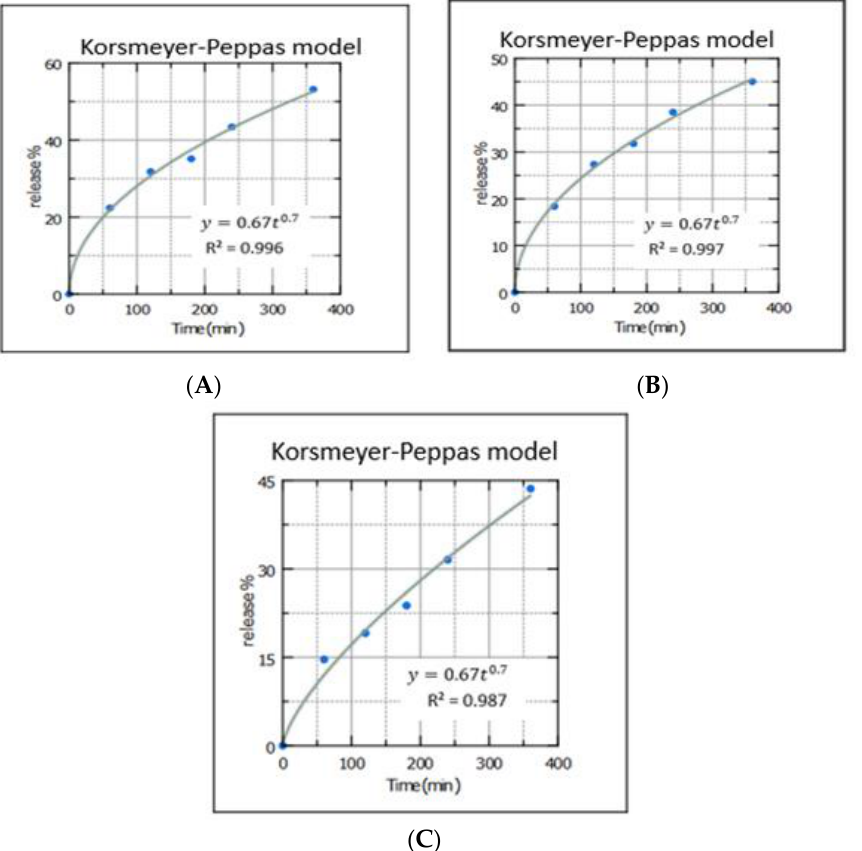
Figure 12. A mathematical model (Korsmeyer–Peppas) was applied to determine the kinetics gov- erning the release of ALS through ( A ) MN-1, ( B ) MN-2, and ( C ) MN-3.